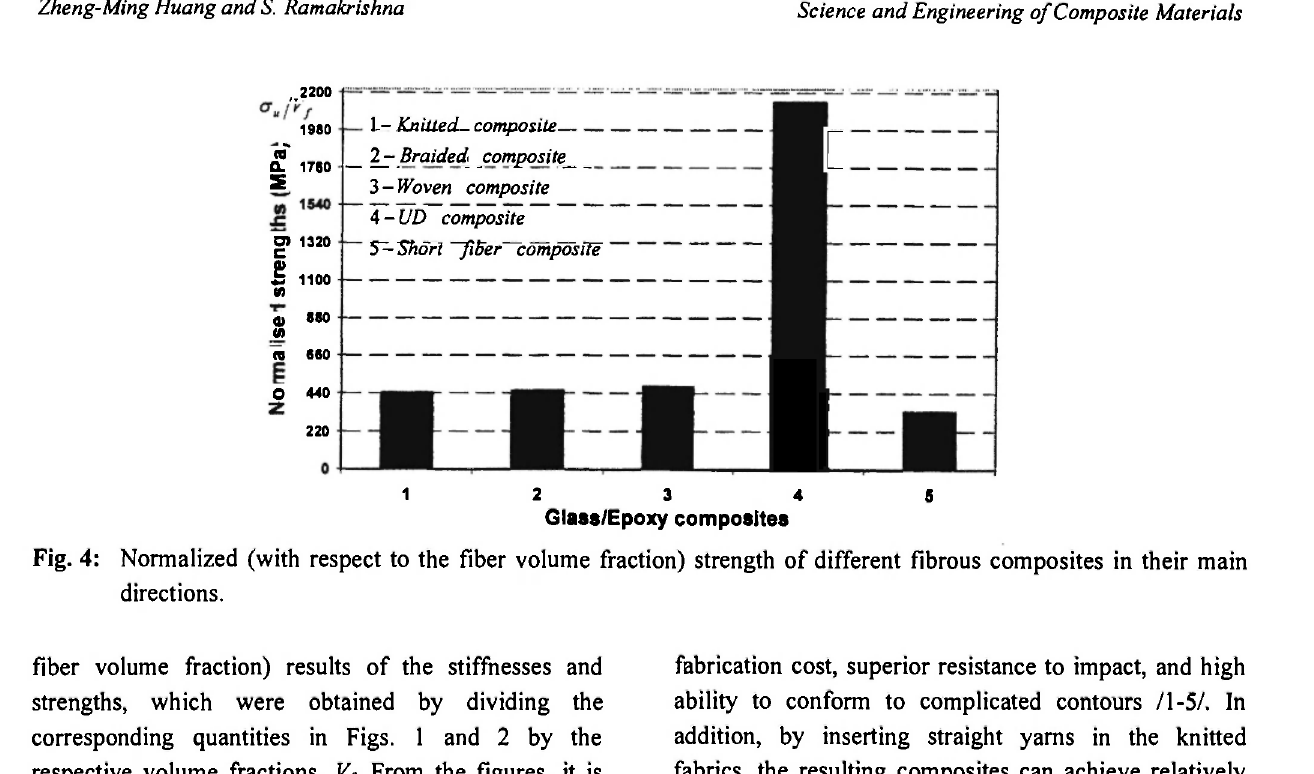
Fig. 4: Normalized (with respect to the fiber volume fraction) strength of different fibrous composites in their main directions.